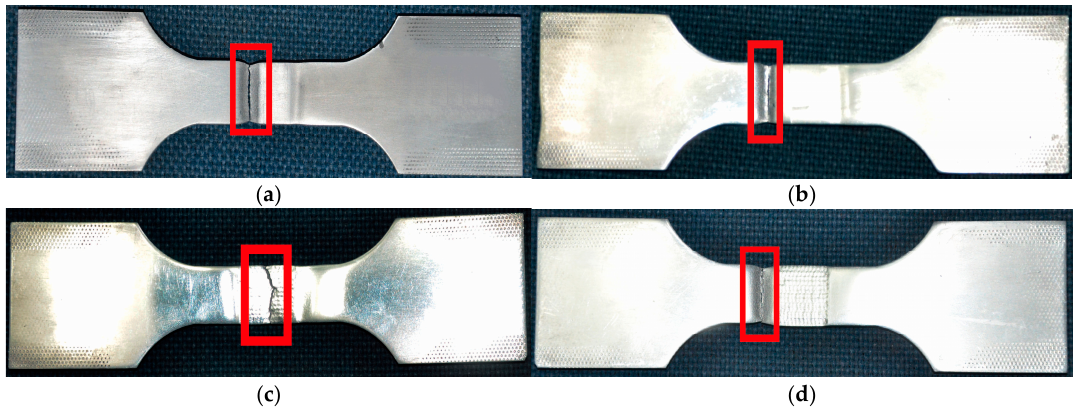
Figure 6. High-cycle fatigue fractures of the specimens subjected to different LSP processes: ( a ) untreated; ( b ) LSP assisted by DSA; ( c ) single LSP; ( d ) double LSP.